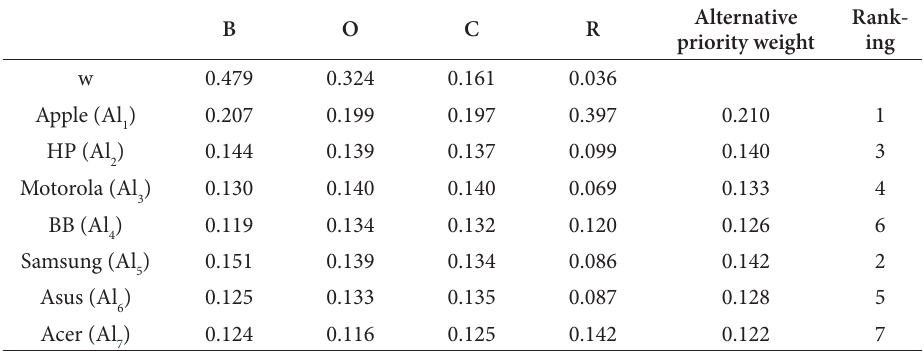
Table 8. Summary of priority weights of the tablet PCs with respect to each criterion by FAHP B O C